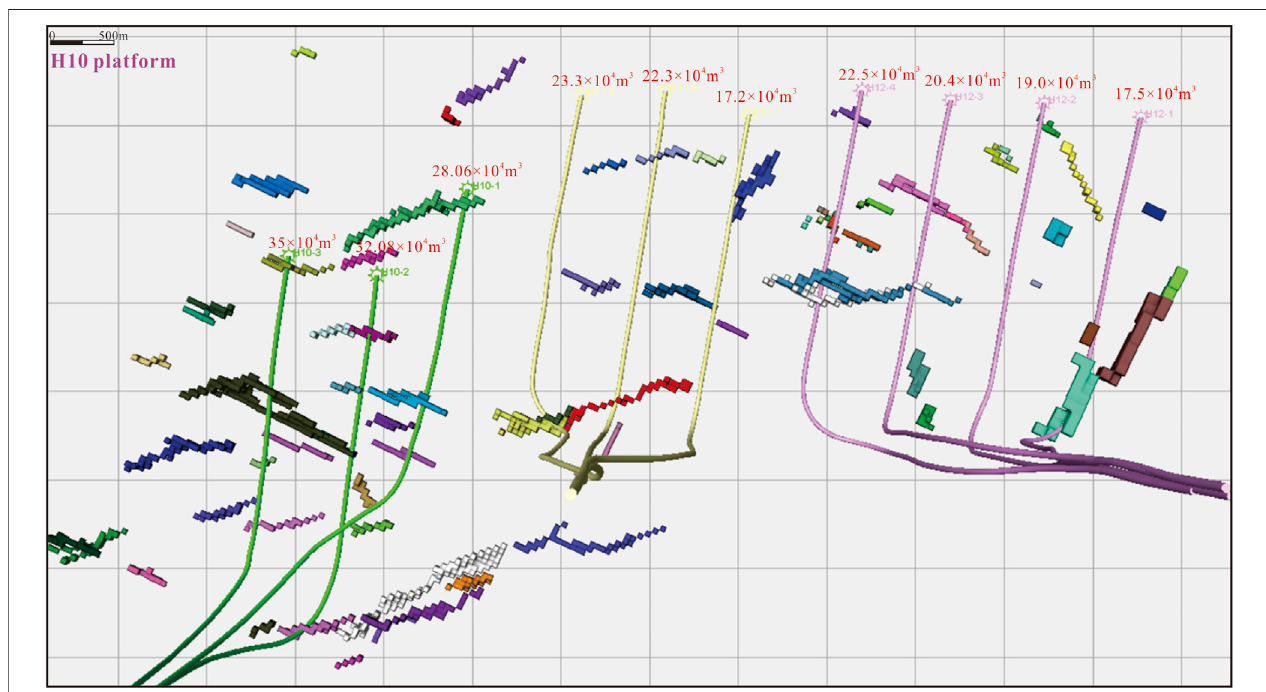
FIGURE 13 | Relationship between fracture development area and test